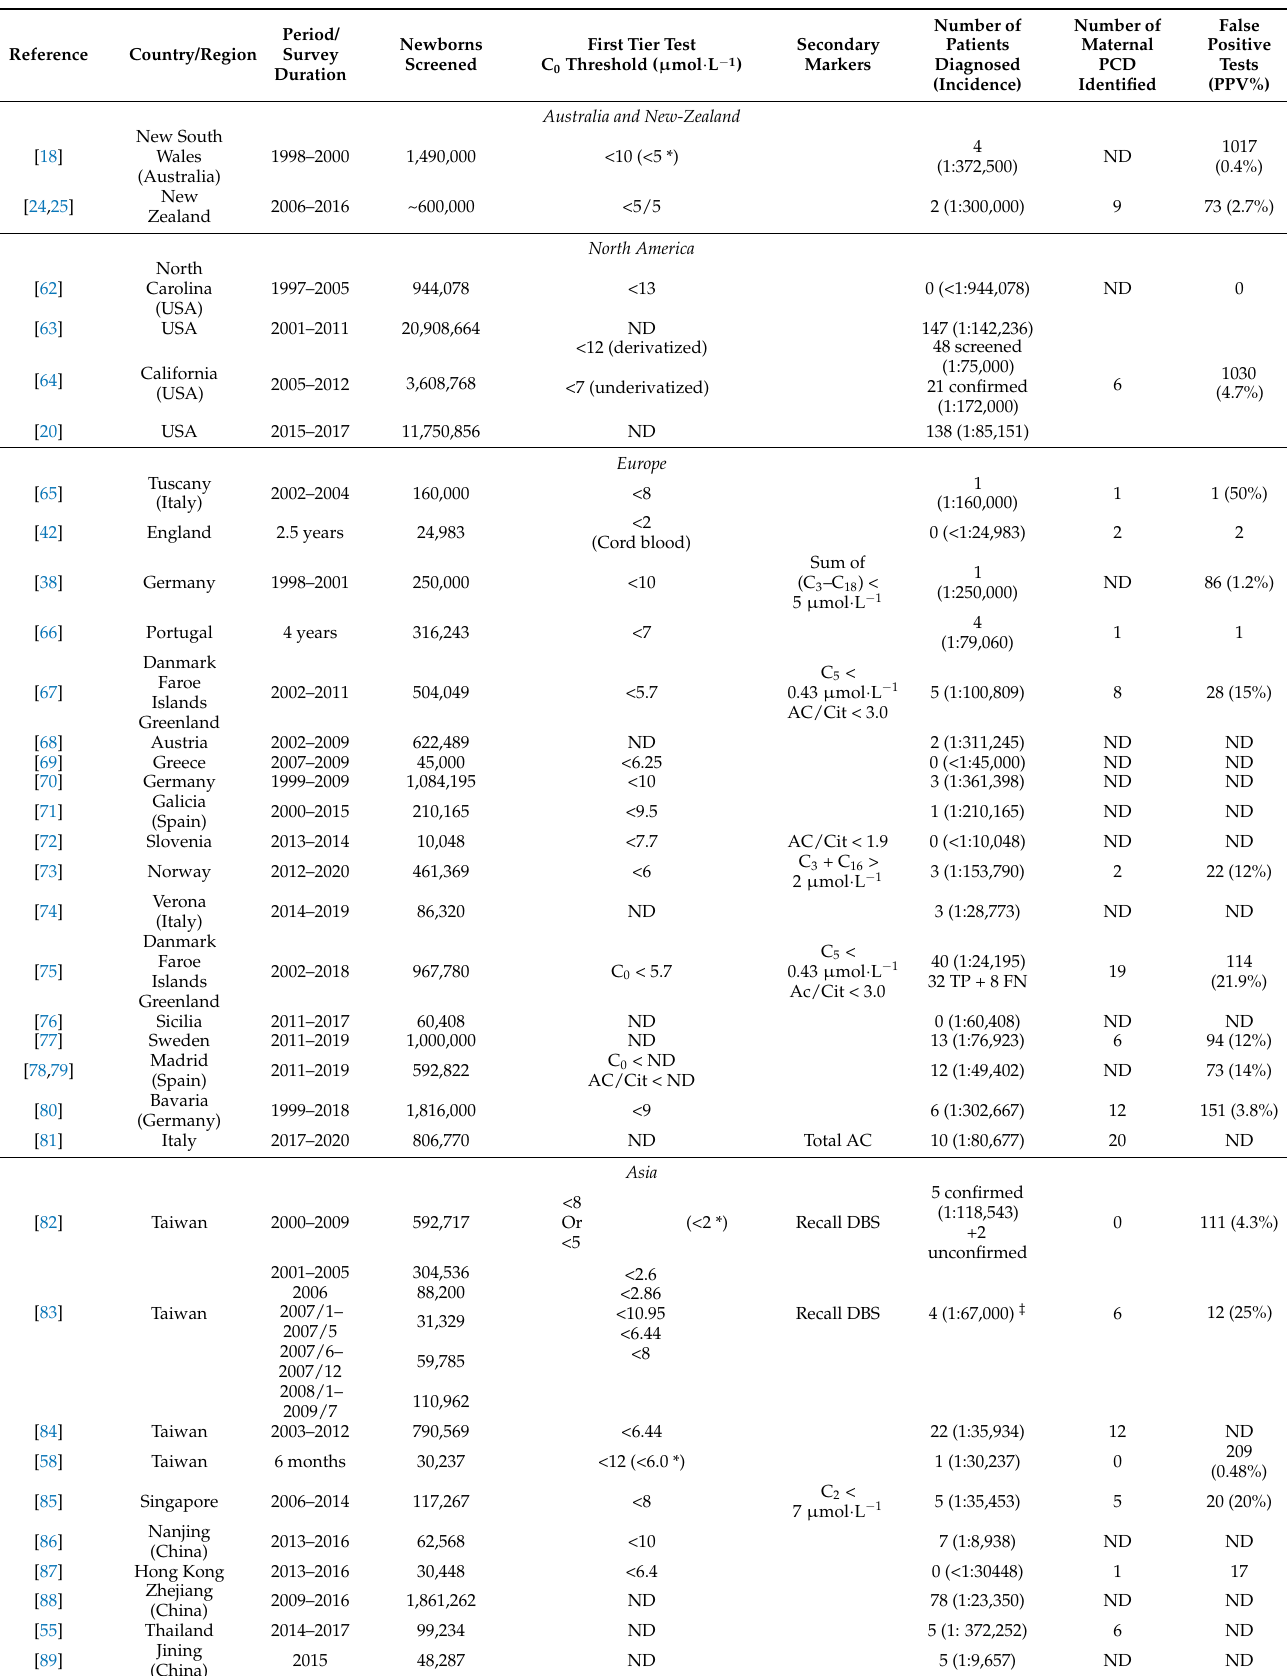
Table 1. Retrospective studies on PCD screening